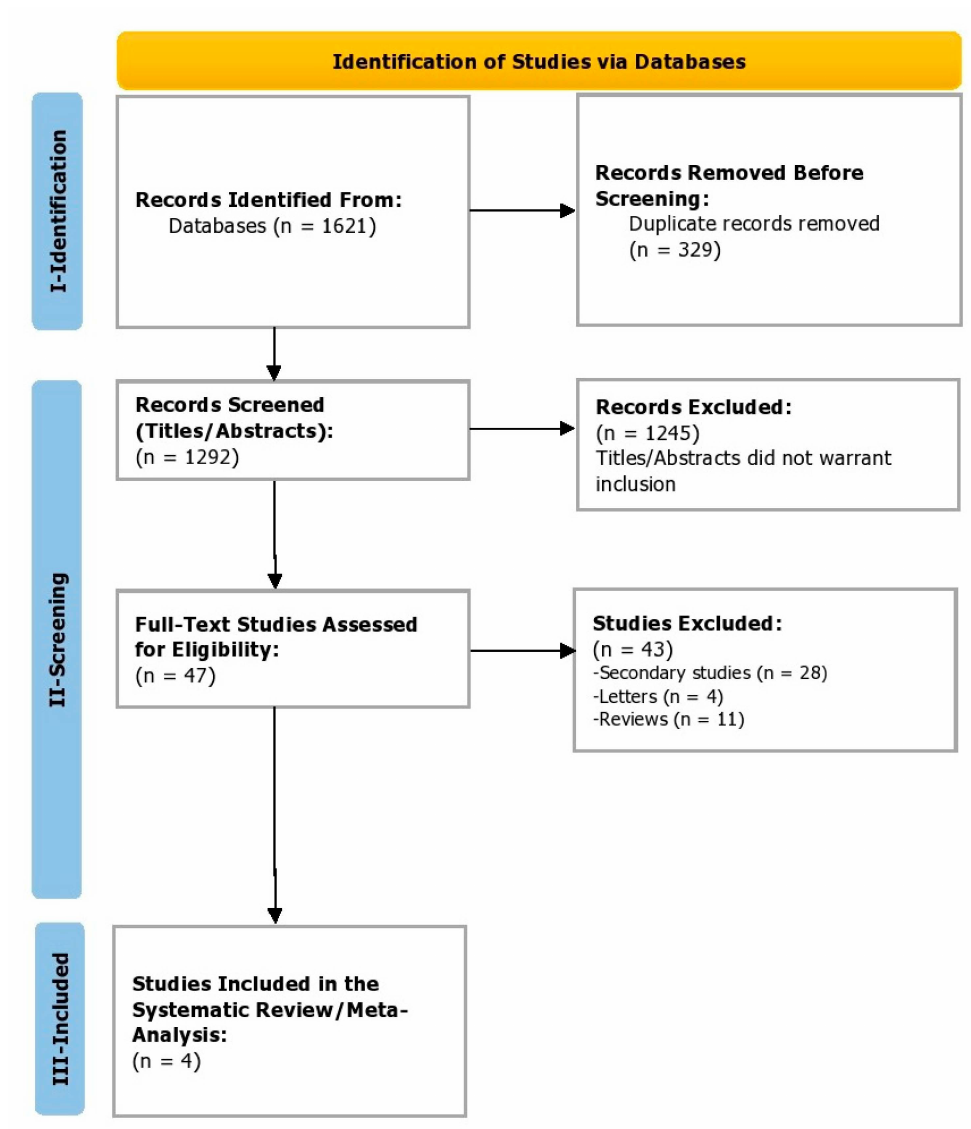
Figure 1. PRISMA study selection